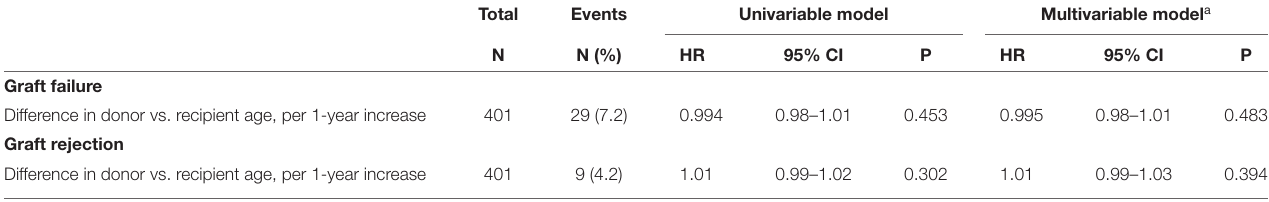
TABLE 3 | Associations of donor-recipient age-matching with graft failure and